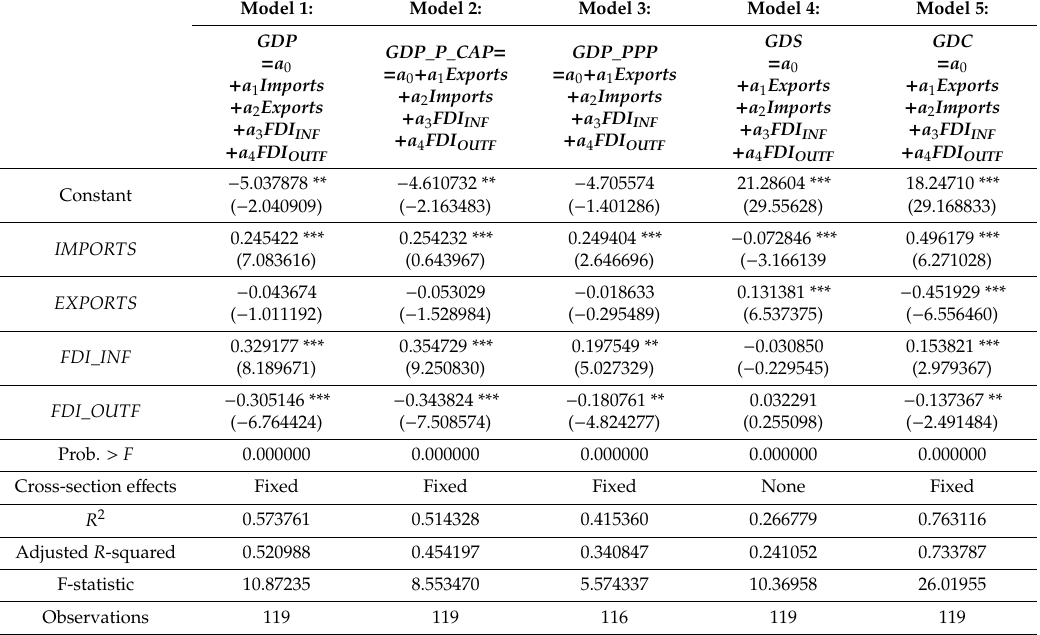
Table 2. Econometric models corresponding to the dependent variables GDP, GDP_P_CAP, GDP_PPP, GDS and GDC for Central and Eastern European